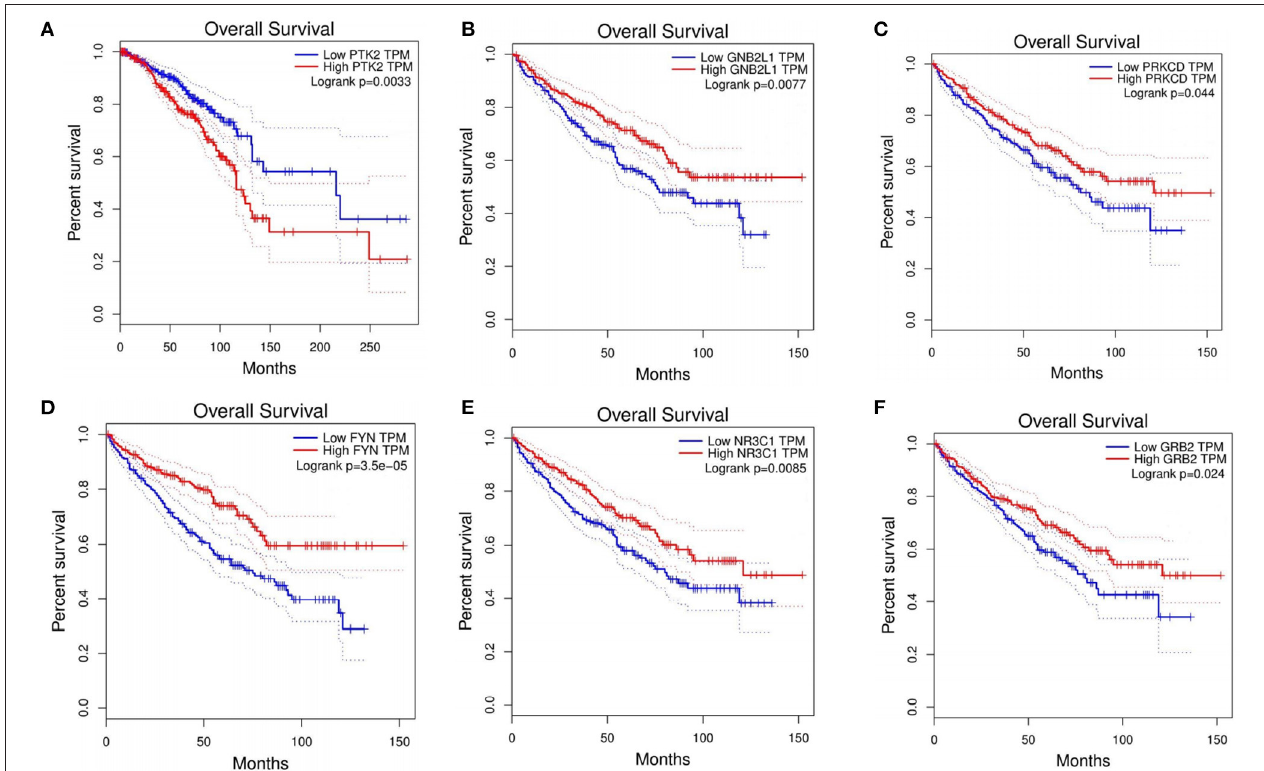
FIGURE 3 | Prognostic value of six genes in cancer patients. (A) PTK2 in BRCA. (B) GNB2L1 in KIRC. (C) PRKCD in KIRC. (D) FYN in KIRC. (E) NR3C1 in KIRC. (F) GRB2 in KIRC.